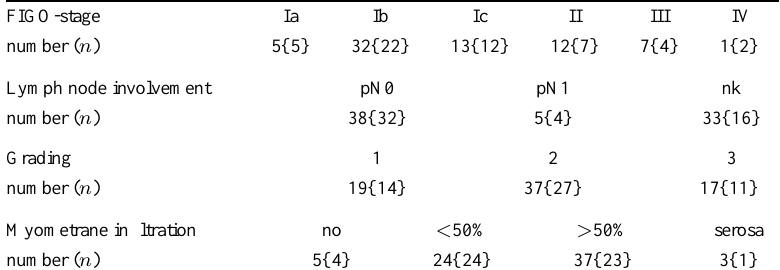
Distribution of clinical-histopathological parameters of patients wit primary endometrial cancer ( n = 73). Distribution of patients with prospective analysis were documented in brackets { n = 52}